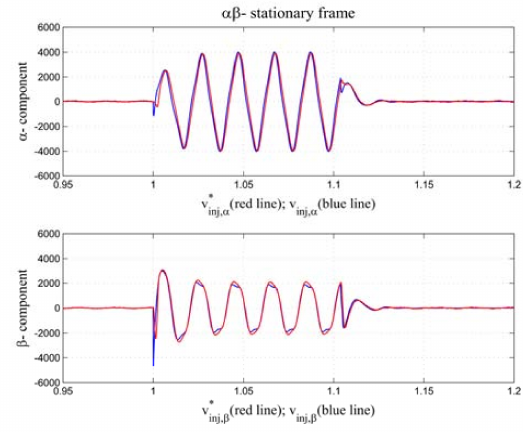
Figure 12. Case 2-Comparison of the difference between v ∗